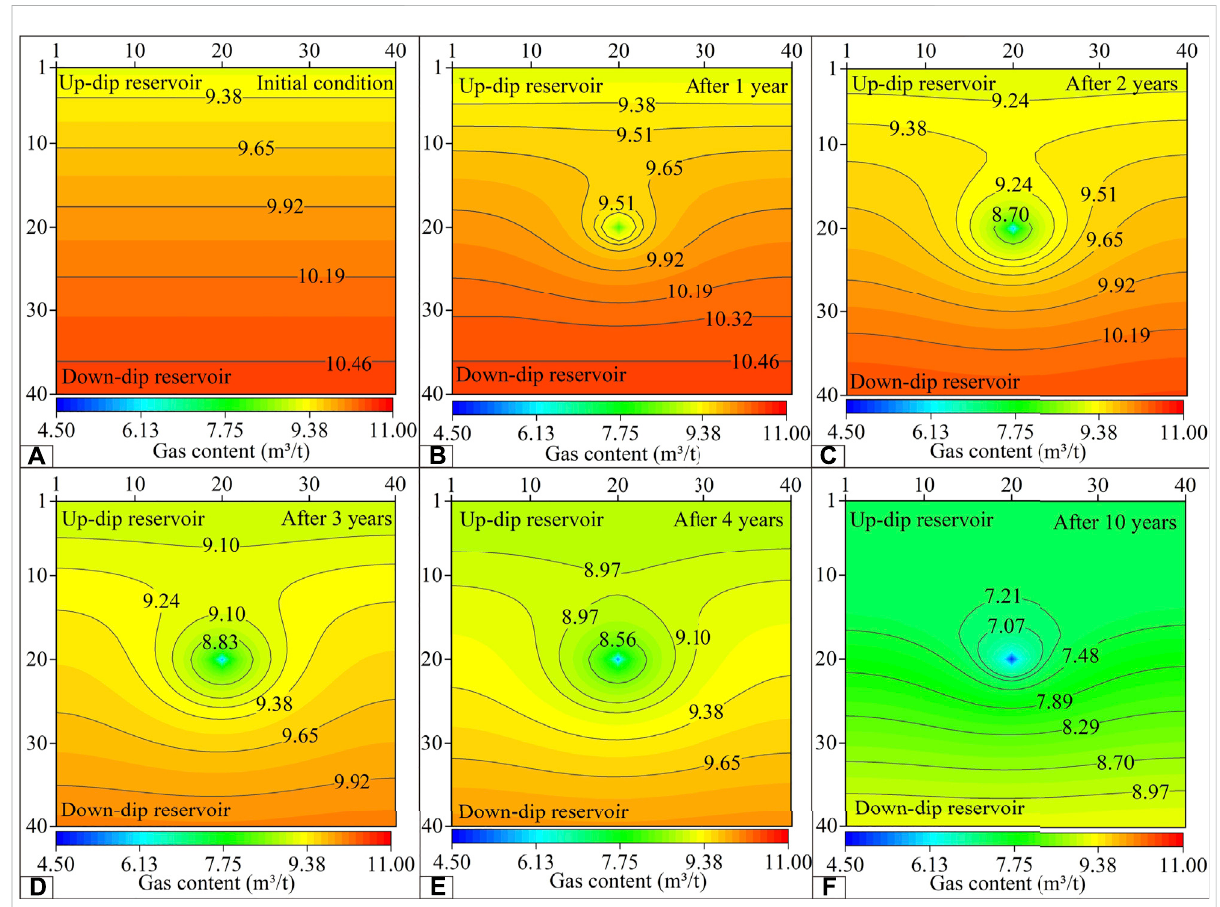
FIGURE 14 (A) Initial reservoir gas content distribution of ISIM. (B) Reservoir gas content distribution after 1 year of drainage in ISIM. (C) Reservoir gas content distribution after 2 years of drainage in ISIM. (D) Reservoir gas contentdistributionafter 3 years of drainage in ISIM. (E) Reservoirgas content distribution after 4 years of drainage in ISIM. (F) Reservoir gas content distribution after 10 years of drainage in ISIM.